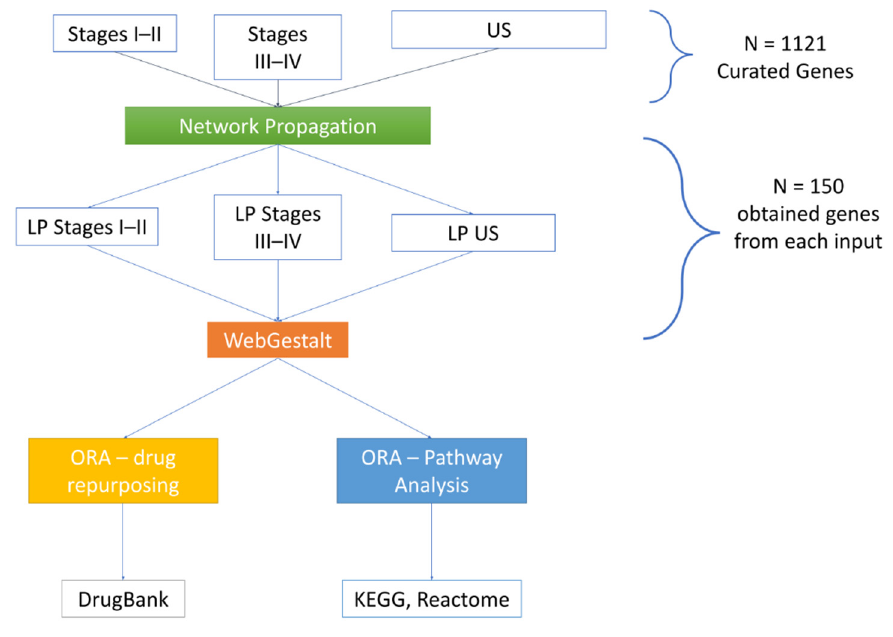
Figure 3. WebGestalt over-representation analysis (ORA) from likely positive (LP) genes obtained after the application of the proposed network-based disease gene prioritisation method. US: unspecified stages.